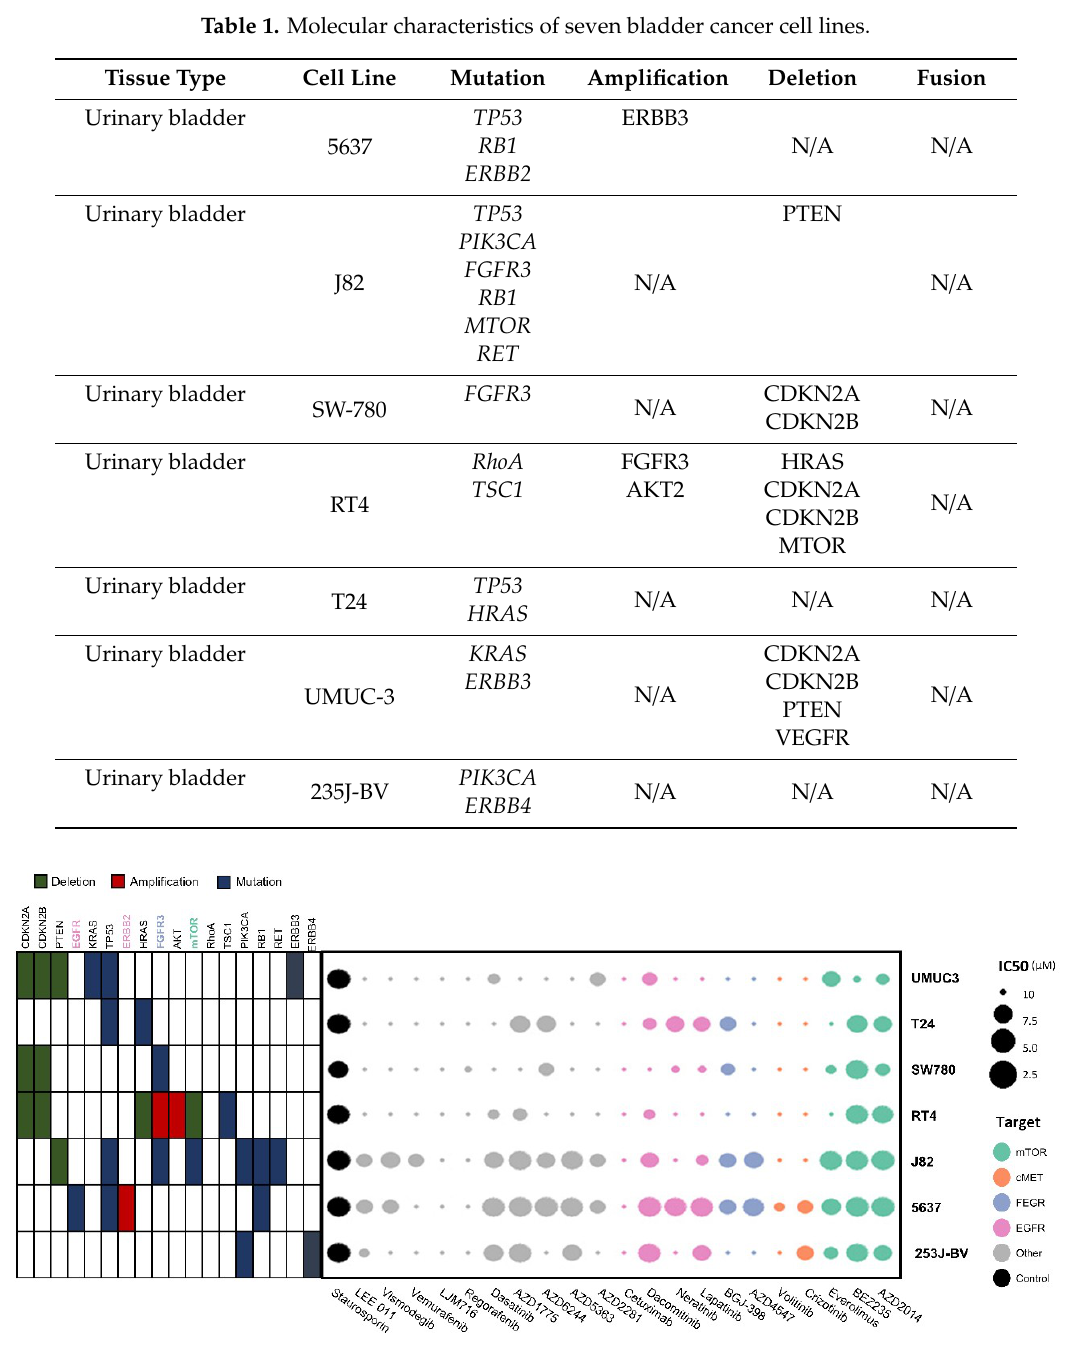
Figure 1. Molecular alterations in cell lines and IC50 values for each drug illustrated as a bubble chart. Using six doses per drug in six replicates, the dose response curves and corresponding IC50 values (μM) were calculated from the scanned images using the S+ Chip Analyzer.